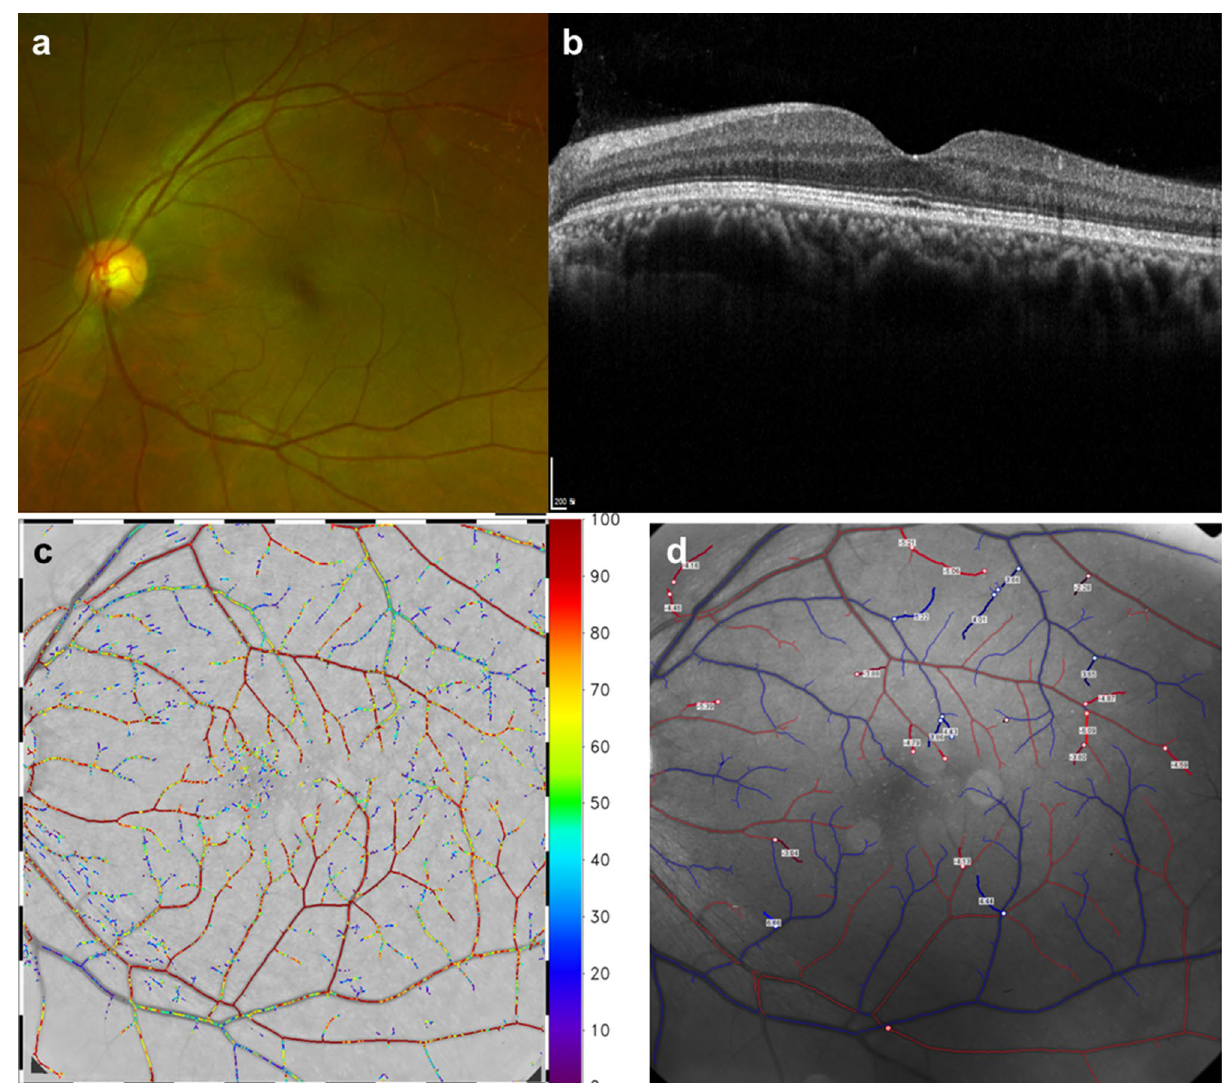
Figure 3. Retinal angiographic images from age-matched control group using fundus photography (a) , optical coherence tomography (b) , and retinal functional imager (RFI) (c,d) . (c) O 2 saturation image and (d) retinal vessel velocity